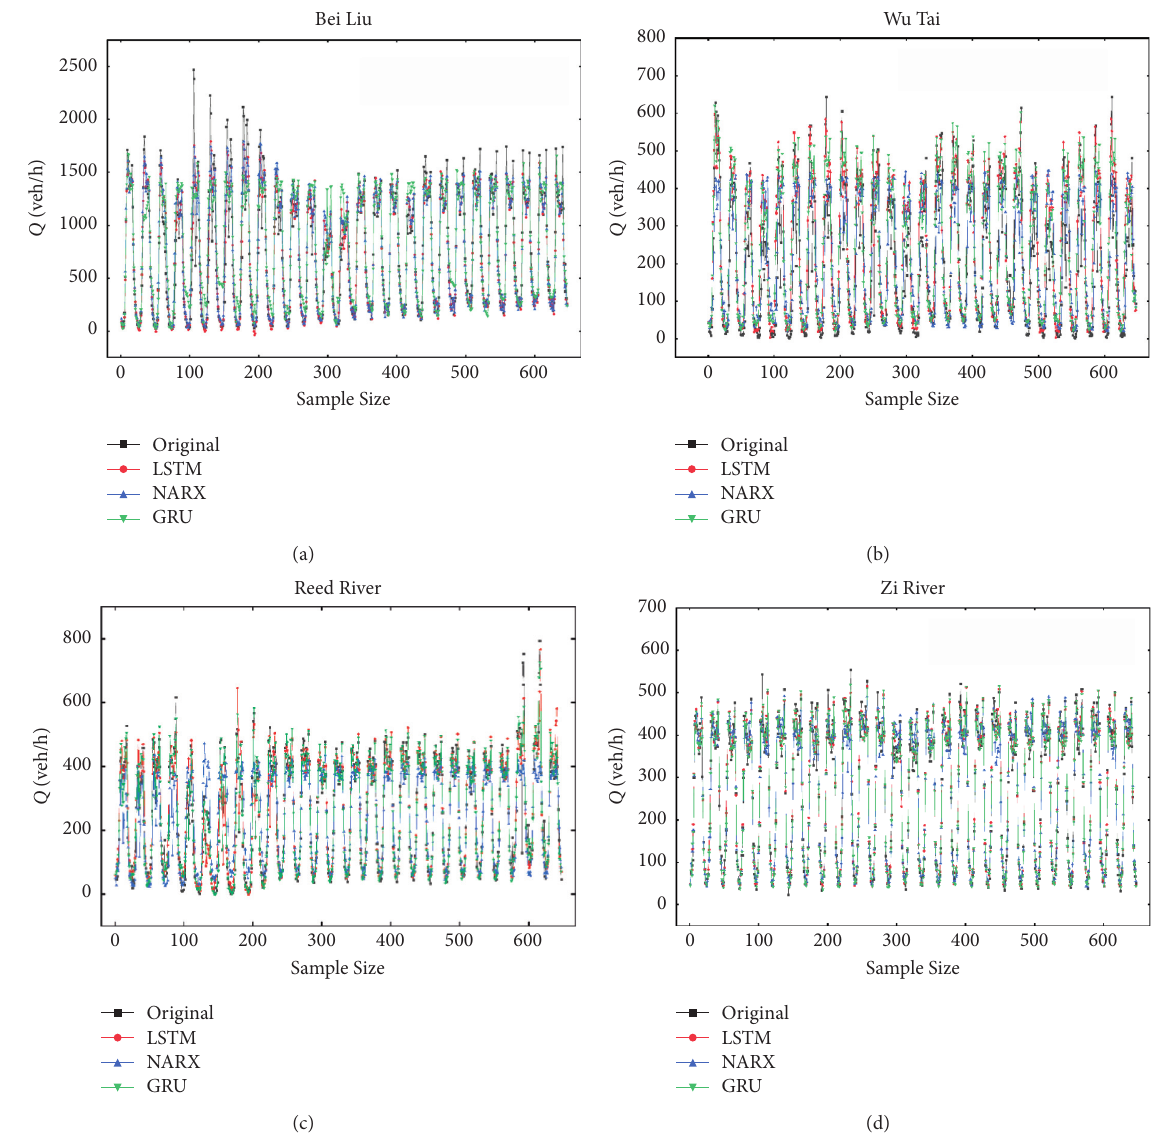
Figure 11: Flow prediction curves for each monitoring station under different prediction models.